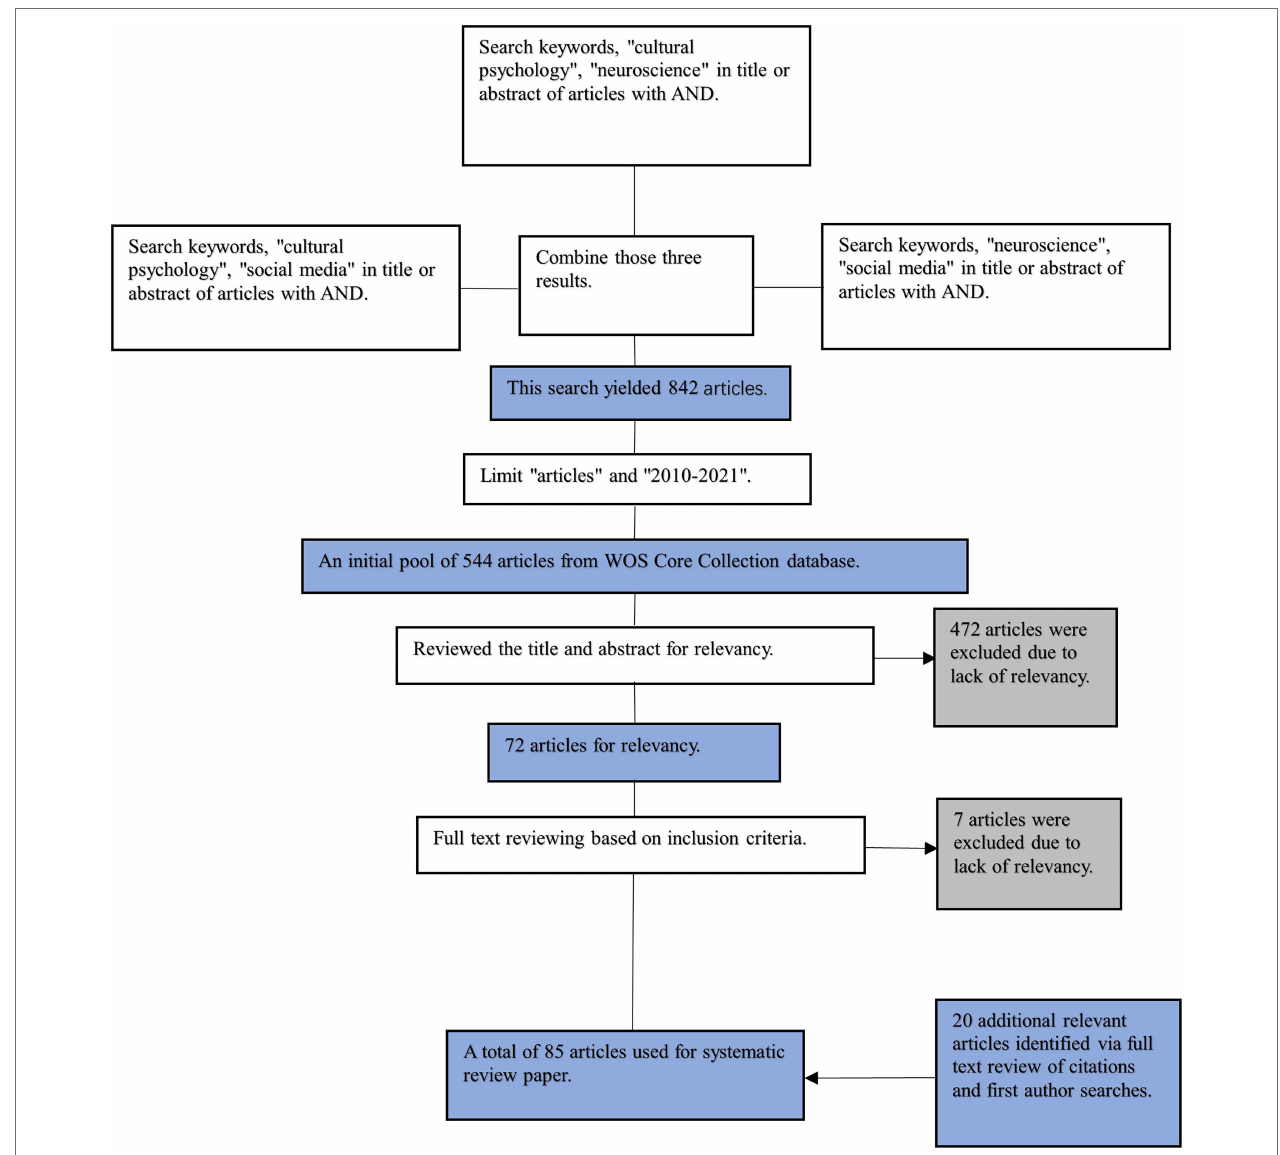
FIGURE 1 | Schematic representation of literature search and selection